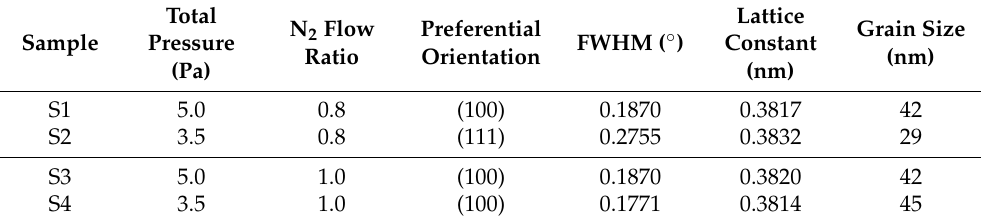
Table 2. Main structural parameters derived from the XRD measurements.